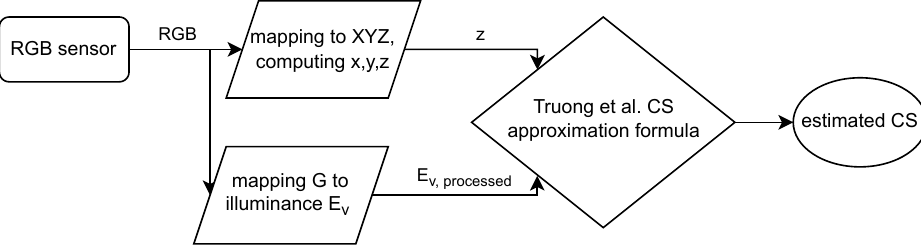
Figure 10. CS estimation from RGB sensor responses for artificial light sources. The 3 × 3 transfor- mation matrix given in Table 3 is used to map RGB sensor responses to XYZ tristimulus values. The function for the calculation of E v,processed from G channel responses is also given in that table. Truong et al.’s CS approximation formula is given by Equation